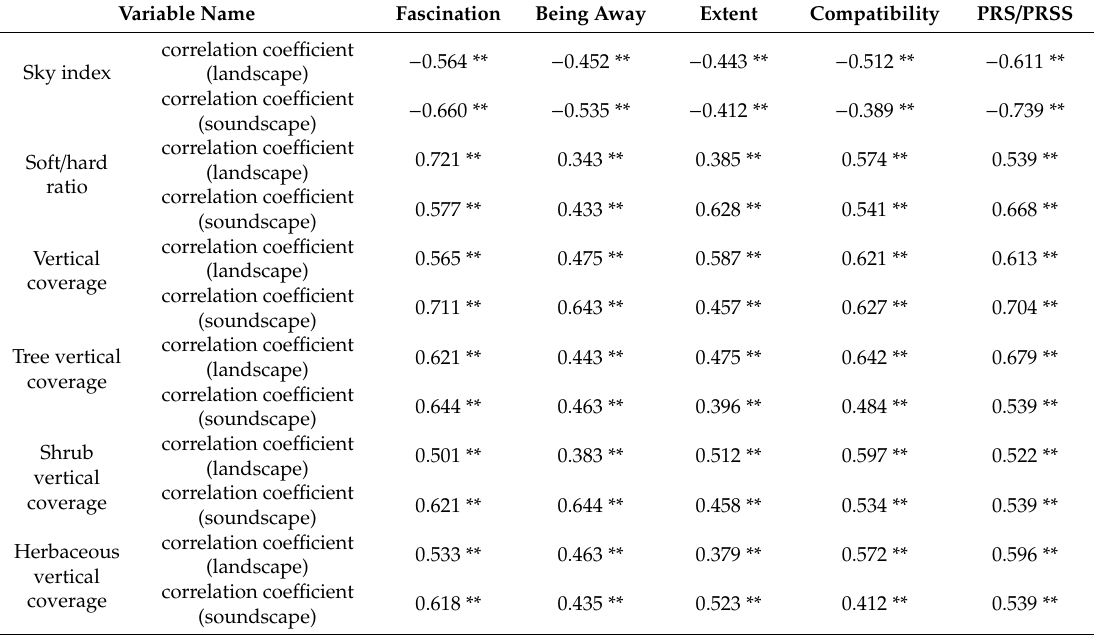
Table 4. Landscape and sound perception